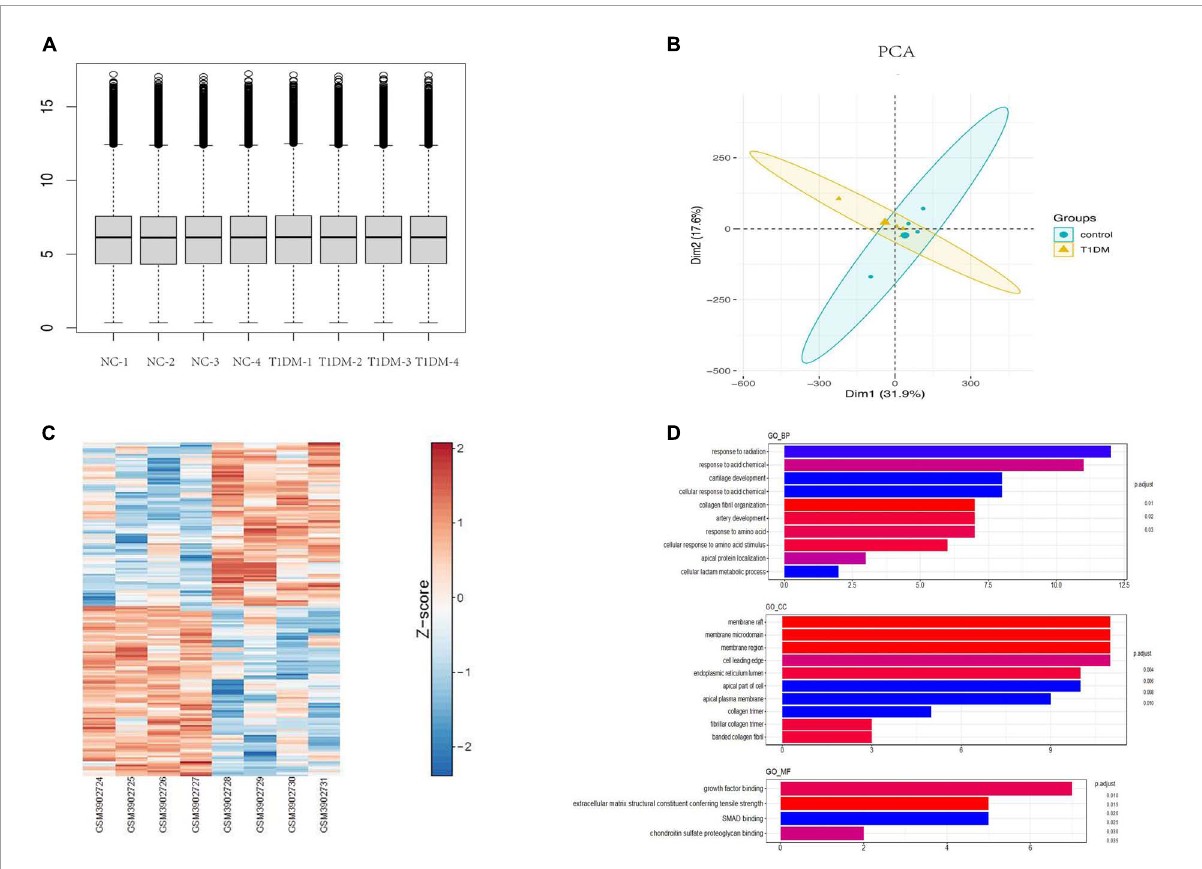
FIGURE3 Bioinformatics analysis of circRNAs in T1D. (A) Normalization of circRNA data. (B) Principal component analysis chart. (C) A heat map according to the circRNA expression level ranking. (D) GO terms analysis of upregulated and downregulated circRNAs. T1D, type 1 diabetes; GO, Gene Ontology; BP, biological process; CC, cellular component; MF, molecular function.